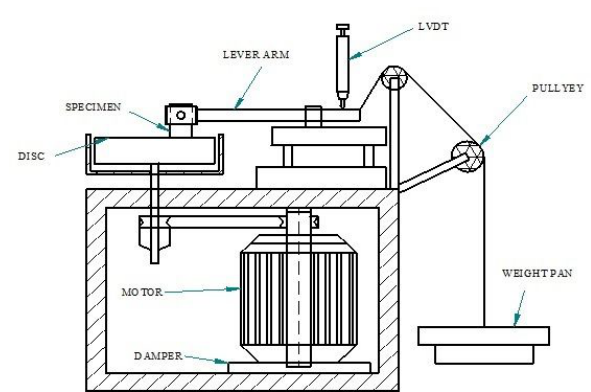
Figure 3: Schematic diagram of wear test apparatus Table 2: Process parameters fixed with their